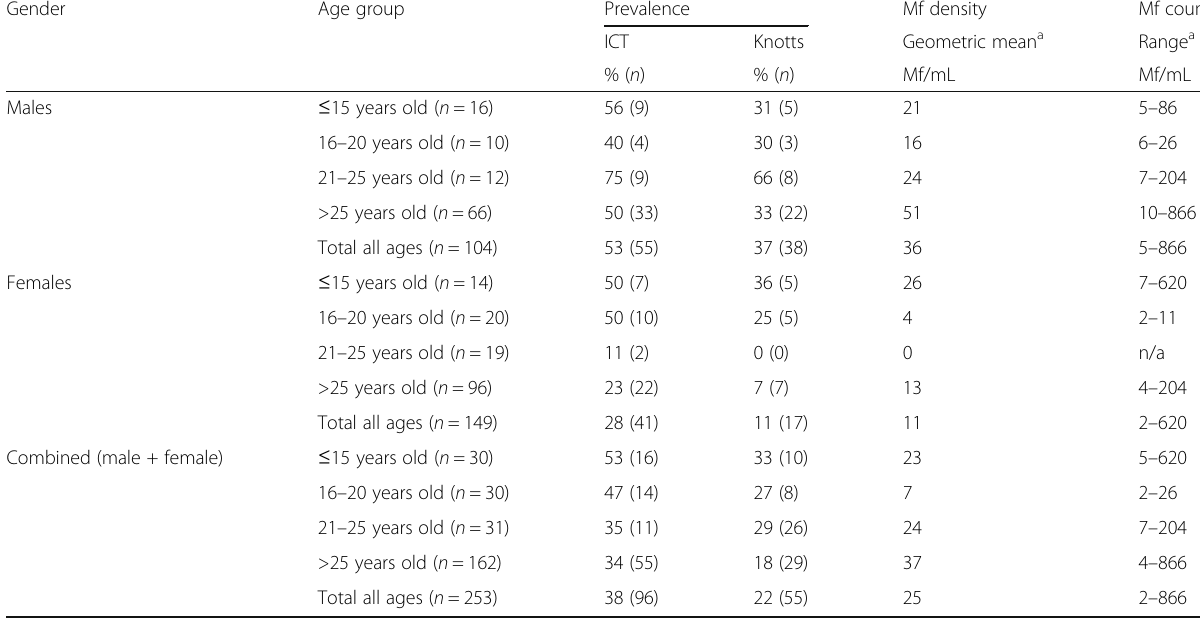
Table 1 Results of filariasis survey on Satawal Island, January 2003 ( n = 253) Gender Age